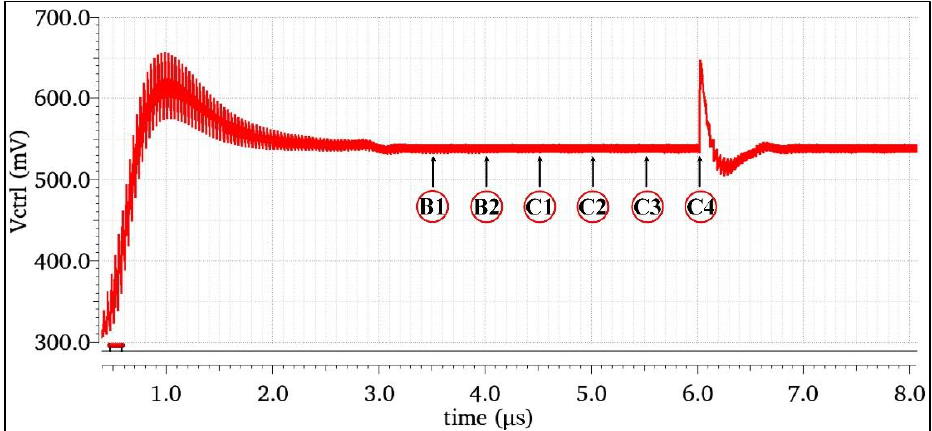
Figure 5. Simulation results of the SET responses of different nodes in a charge pump.